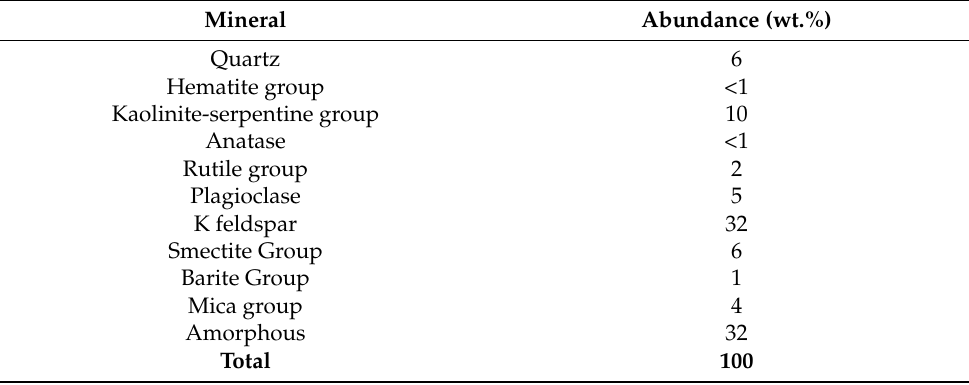
Table 2. Modal mineralogy of the feed determined via XRD analysis. Mineral